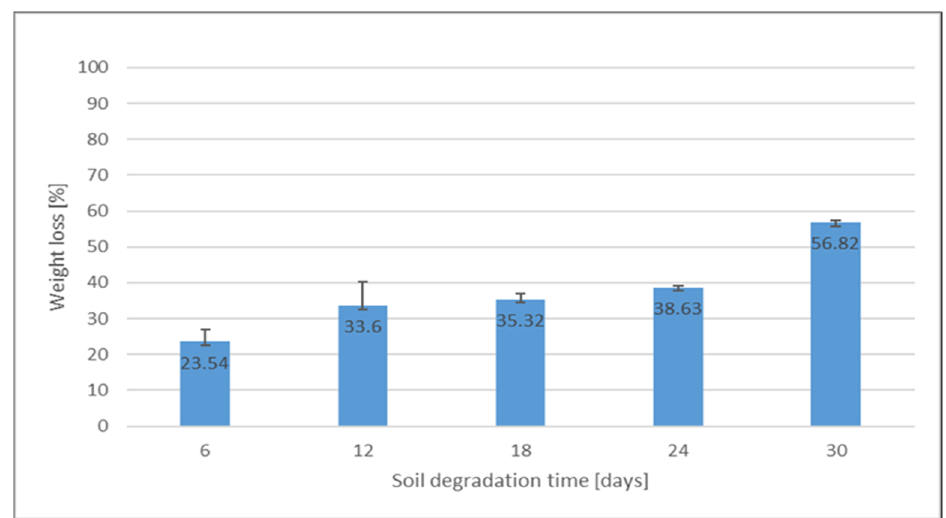
Figure 4. Percentage weight loss of CSH film samples during soil burial test.